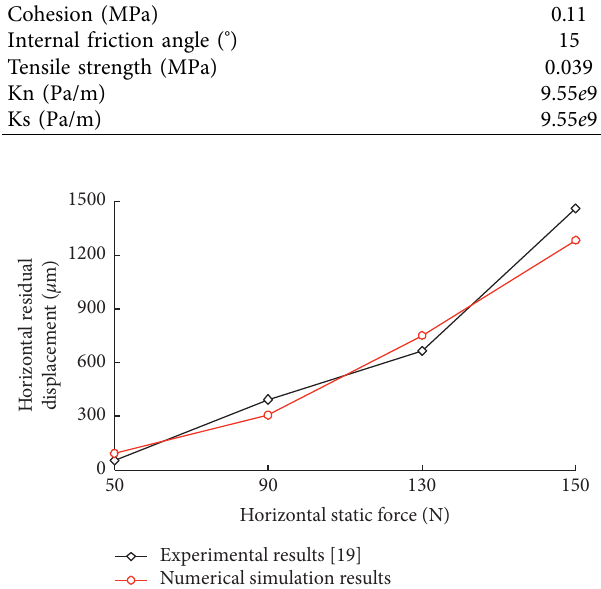
Figure 2: Comparison curve between numerical simulation and experimental